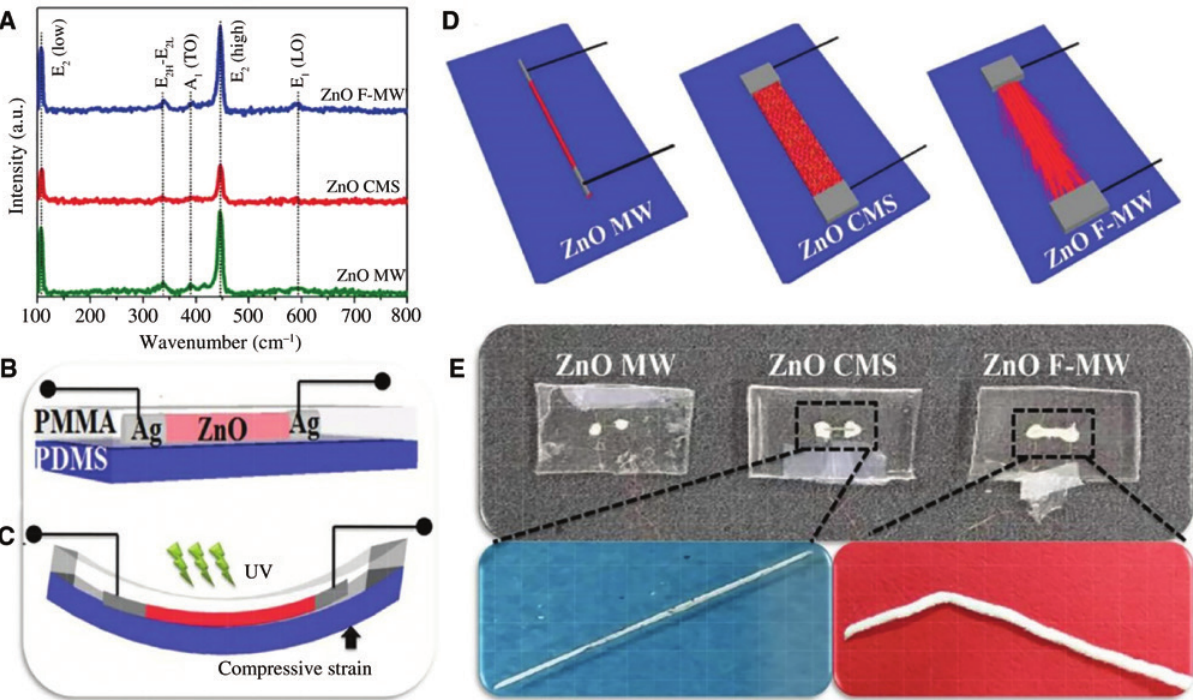
Figure 5: Structure and photospectrum of this as-fabricated ZnO. (A) Rama spectrum of ZnO microarchitectures. (B) Schematic representation of as-fabricated PD. (C) Compressive strain-induced behavior of PD. (D) Schematic view of ZnO device architectures. (E) Optical images of as-fabricated PD devices using ZnO MW, ZnO CMS, and ZnO F-MW. Reproduced with permission from Ref.